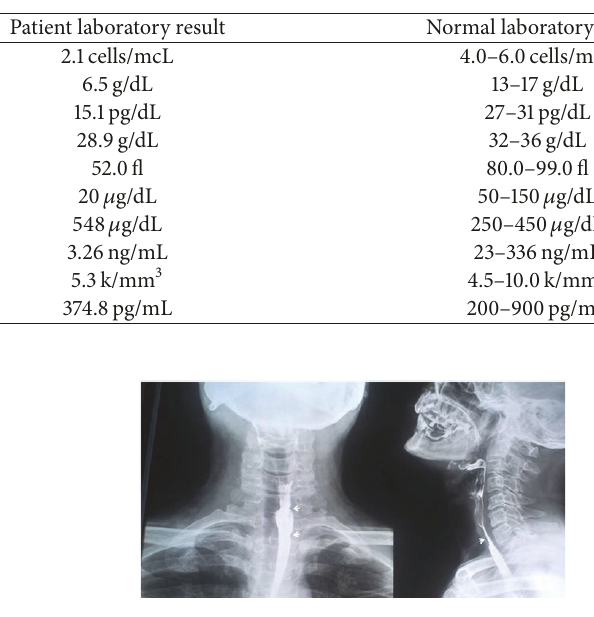
Table 1: Laboratory results.